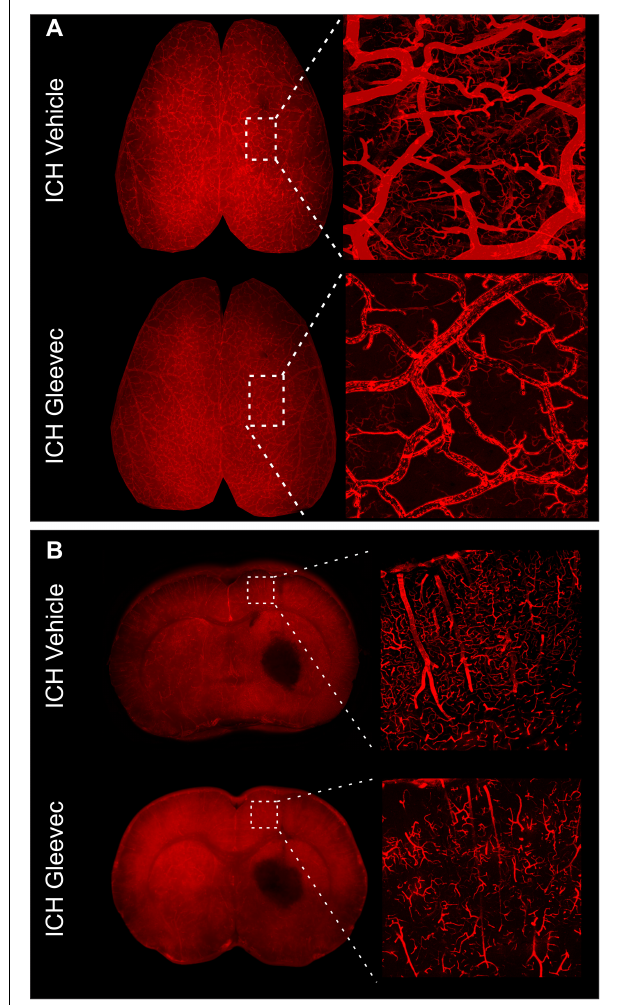
FIGURE 4 | Gleevec treatment does not improve the morphology of the cortical vasculature. (A) Vessel painted brains from the axial surface were imaged using confocal microscopy and then subjected to classical vascular analysis. ICH vehicle and ICH Gleevec animals exhibited uniform staining of large, intermediate and small vessels within the cortex. Note the apparent loss of fine branching vessels in the ICH + Gleevec rats. (B) In coronal sections from vessel painted brains, the cortical vessels descending into the cortex exhibited a dense plexus of vessels in ICH Vehicle treated rats. In contrast, ICH Gleevec treated rats showed a reduced vascular plexus with fragmented vessels and regions with overt loss of vasculature (see Figure 5 for